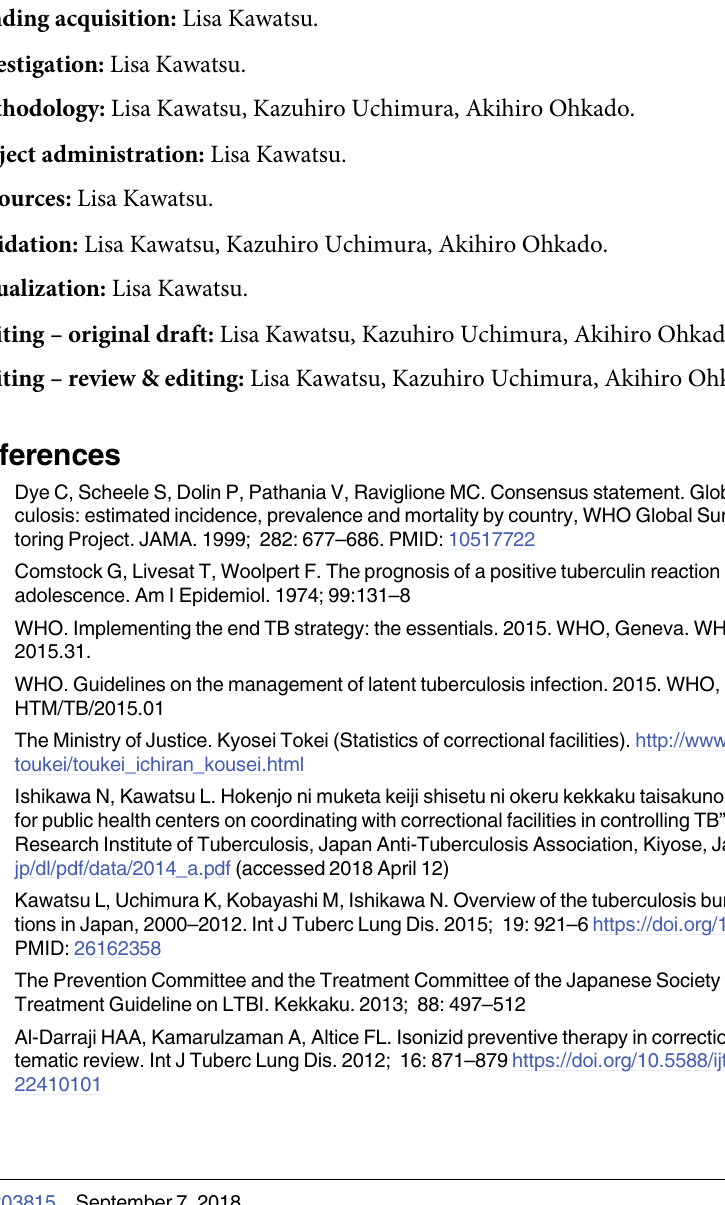
S1 Table. Raw data of the 88 LTBI patients, without the personal